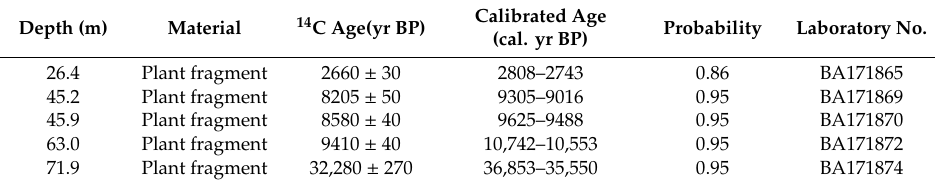
Table 1. AMS 14 C ages of core RGK15.